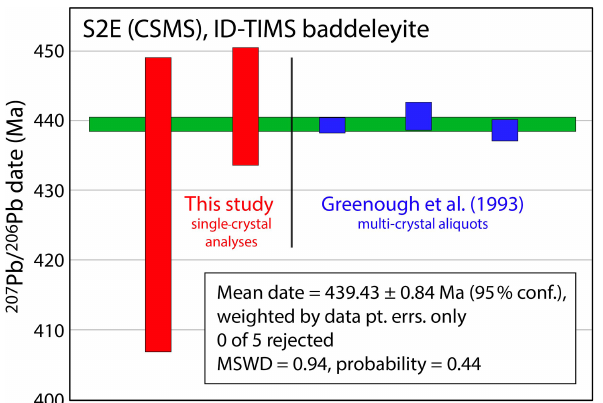
Figure 11. Recalculated age for the Cape St. Mary’s sills using only the ID-TIMS data of Greemough et al. (1993) and this study which are < 3%